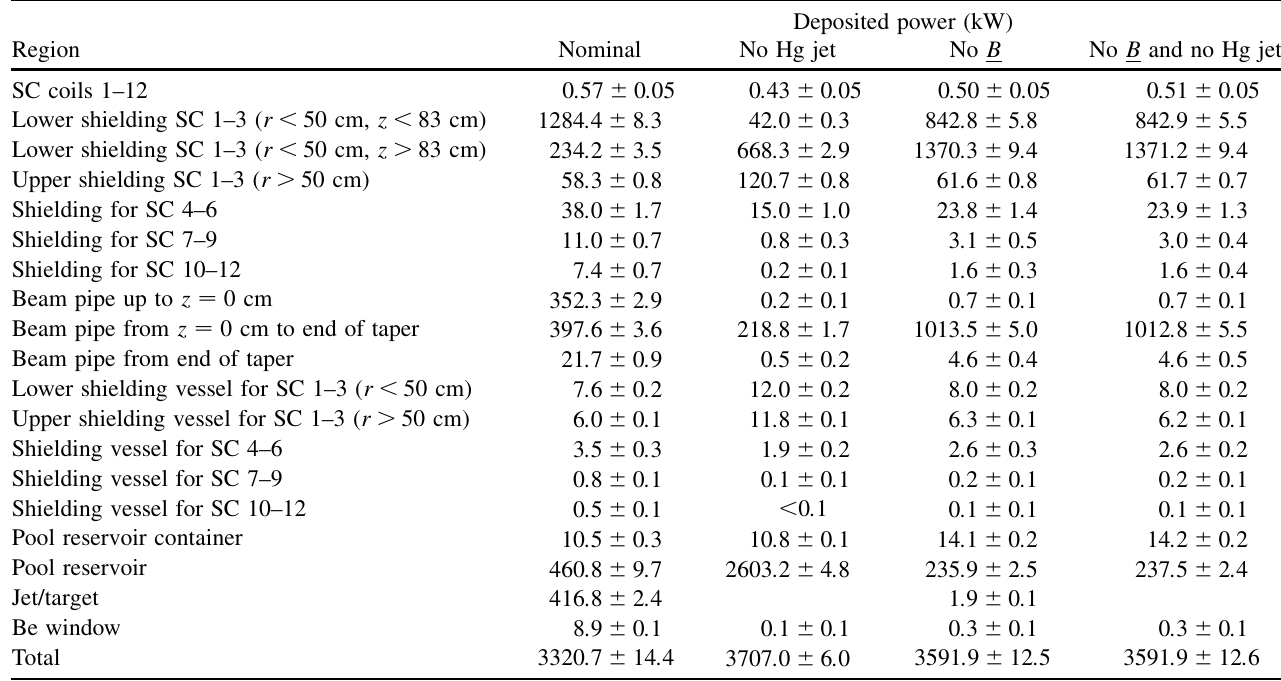
TABLE III. Power deposition in various regions of the increased shielding geometry configuration for the mercury jet for a range of operational failure